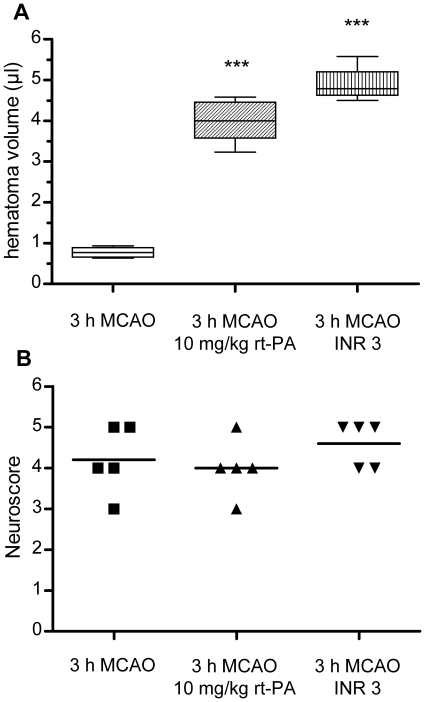
Comparison of hemorrhagic transformation 24 h after MCAO in mice with different antithrombotic pretreatment.A) Comparison of HT volumes in mice who received i.v. thrombolysis with 10 mg/kg human recombinant t-PA directly prior to reperfusion (middle, n = 5) and mice who were effectively anticoagulated to an INR of approximately 3 at the onset of 3 h MCAO (right, n = 4 after exclusion of outlier, see Fig. S1) with mice who underwent 3 h MCAO without any treatment (left, n = 5). Hematoma volume was determined by a hemoglobin assay. Data are depicted as box and whiskers plots showing the 25 to 75 interquartile range and the extreme values. Statistical significance was analyzed with ANOVA and bonferroni correction for multiple testing. *** p<0.001. B) Neuroscores were assessed for statistical significance with a Kruskal-Wallis test and Dunn's correction. Differences between groups were not significant (median values 4, 4 and 5).